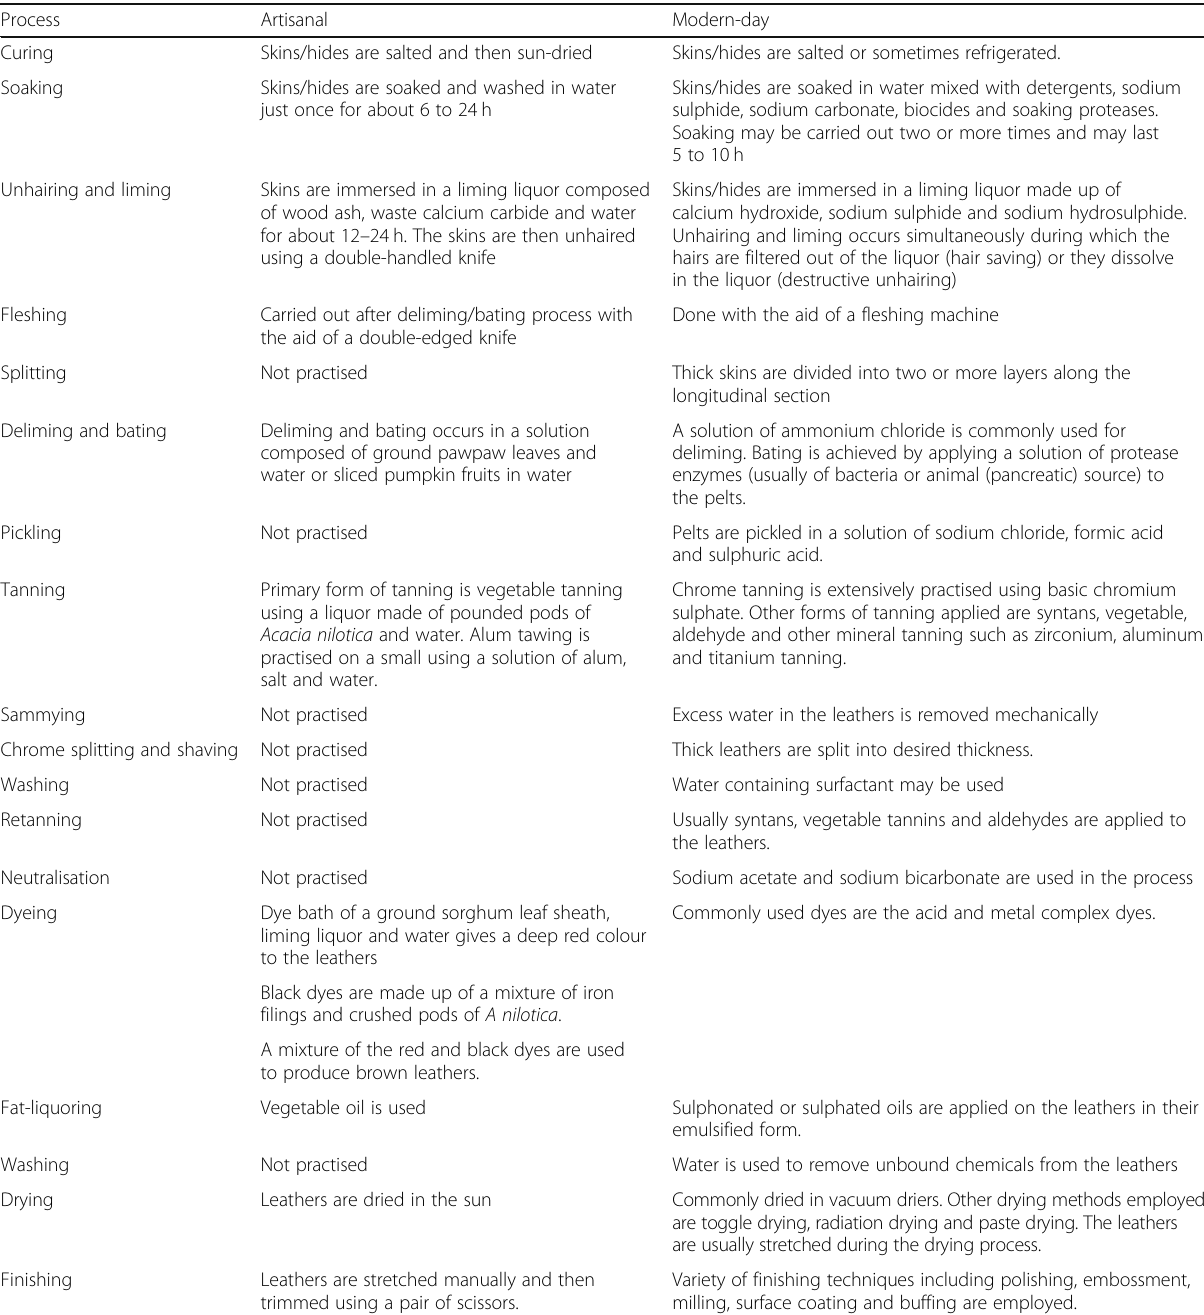
Table 1 Comparison between artisanal and modern-day leather making processes Process Artisanal Modern-day Curing Skins/hides are salted and then sun-dried Skins/hides are salted or sometimes refrigerated. Skins/hides are soaked in water mixed with detergents, sodium sulphide, sodium carbonate, biocides and soaking